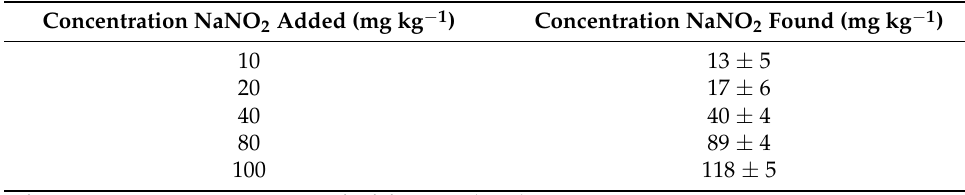
Table 3. Recovery study for sodium nitrite ham samples.